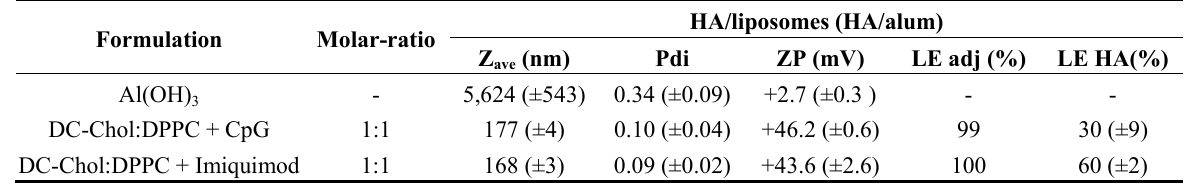
HA/liposomes (HA/alum)